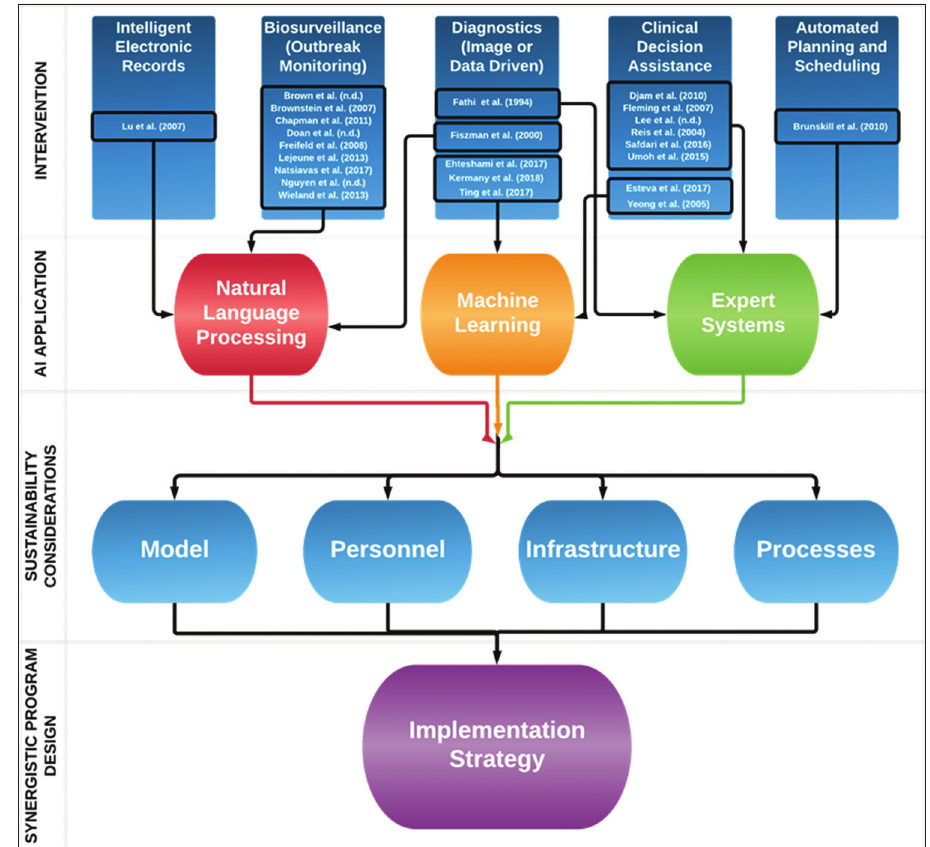
Figure 1: A process for development of an artificial intelligence driven global health